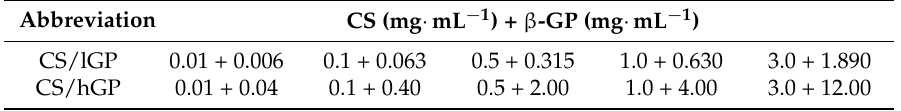
Table 4. Different concentrations of β -GP crosslinked CS used for cytotoxicity studies.